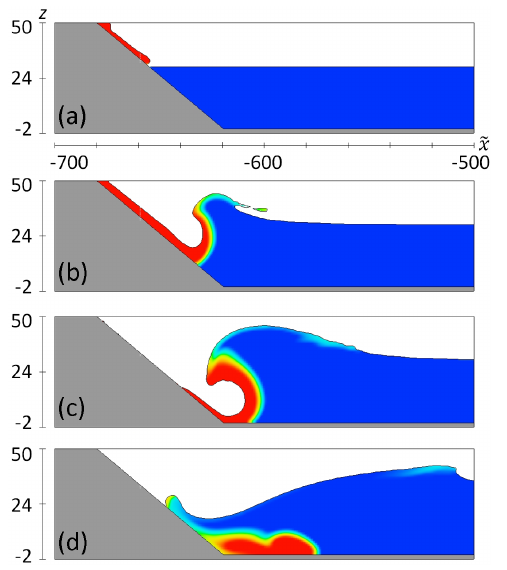
Figure 4. The impact of the avalanche at time (a) 4.6s, (b) 6.6s, (c) 8.6s and (d) 11.6s. Water, which is used as the model avalanche, is marked red and water in the reservoir blue; all length dimensions are in (m).